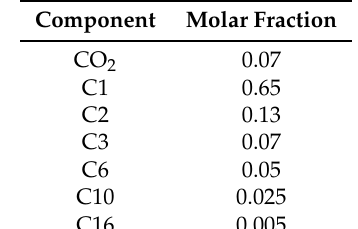
Table 1. Fluid mixture composition.